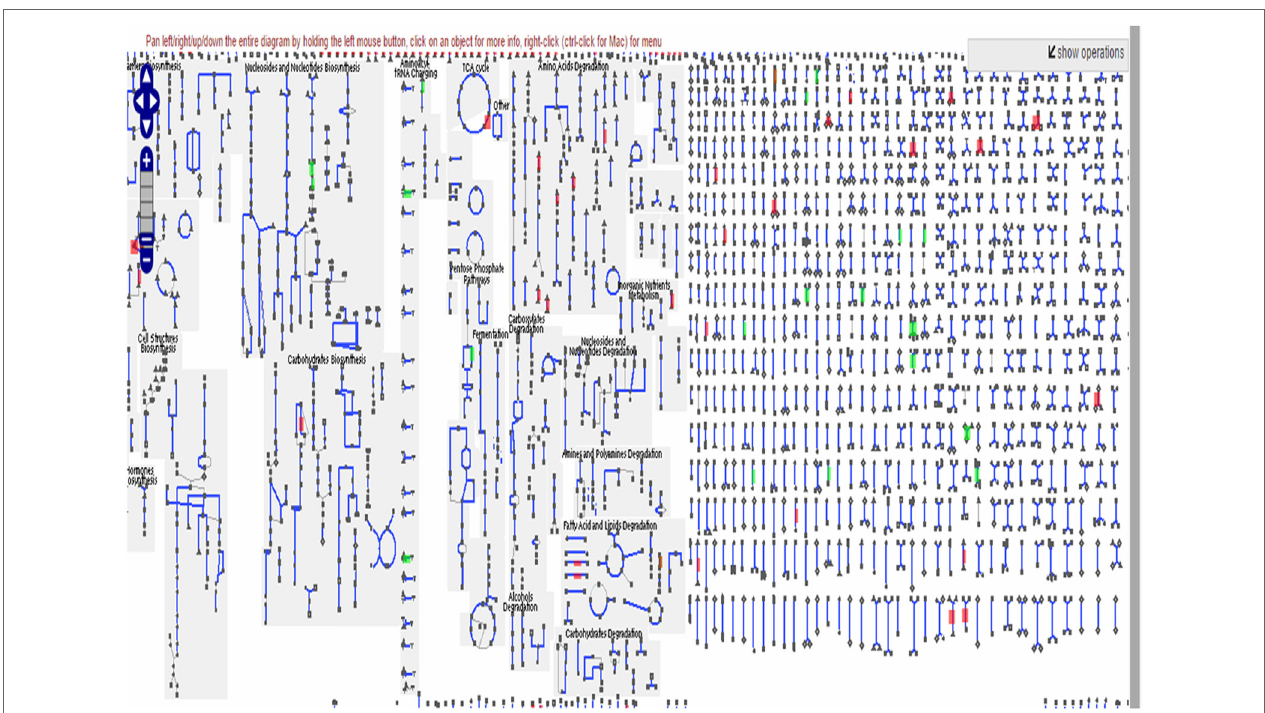
FigUre 4 | BioCyc metabolic map illustrating the different differentially expressed genes involved in tsetse fly metabolic pathways. The genes activated by the infection are displayed in red, whereas the repressed genes are displayed in